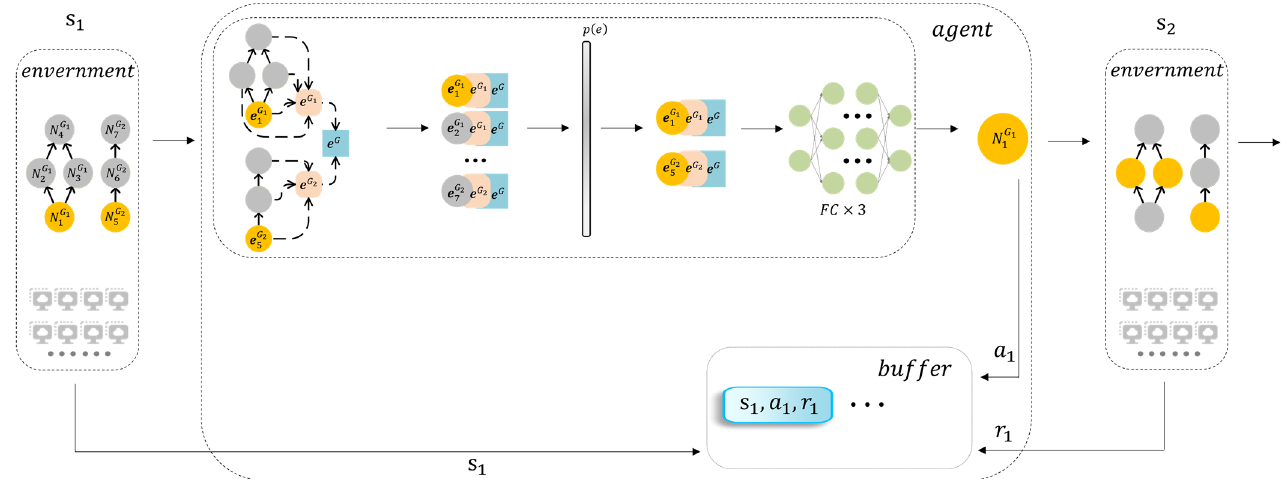
Figure 4. Scheduling process.